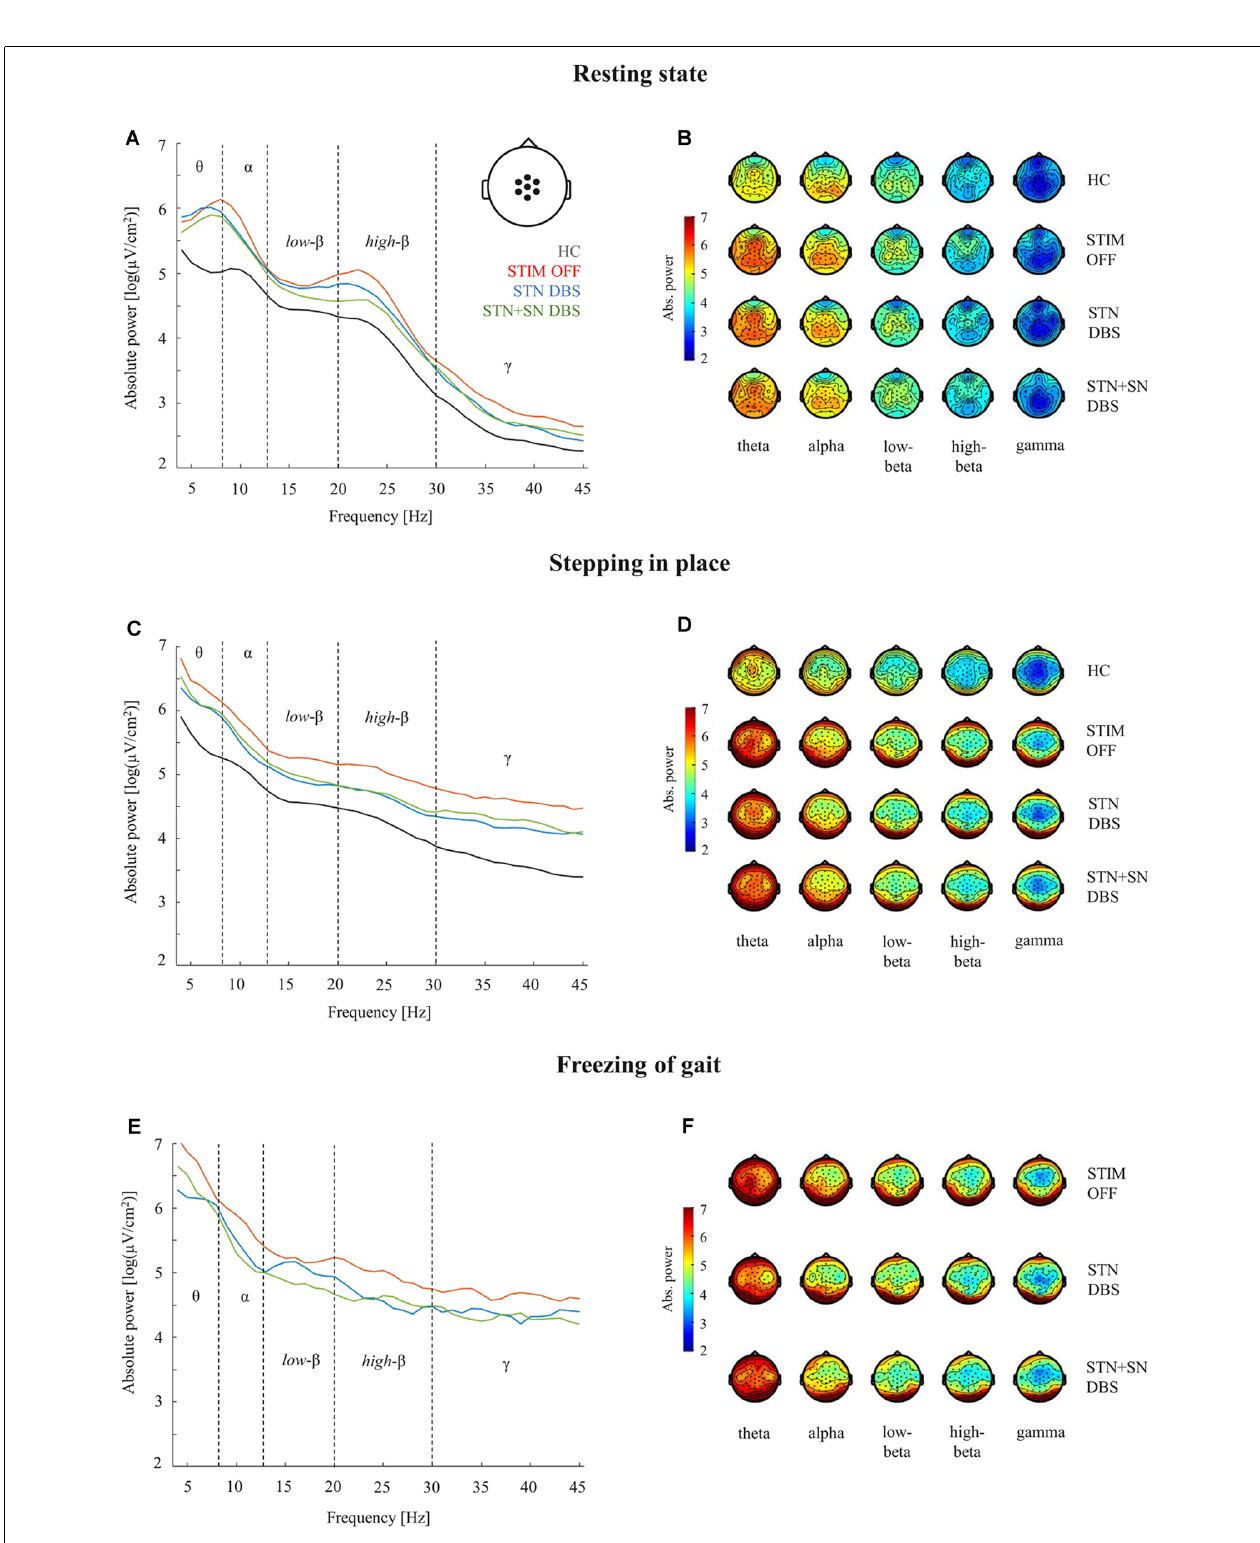
FIGURE 3 | Cortical activity during resting-state, stepping in place, and during freezing of gait episodes. Analyses of absolute power in healthy control persons and PD patients for the three DBS conditions were performed in five frequency bands (theta 4–8 Hz, alpha 9–13 Hz, low-beta 14–20 Hz, high-beta 21–30 Hz, gamma 31–45 Hz). Panels (A,C,E) : comparison of absolute power spectra in the central ROI (pictogram in panel A ). Panels (B,D,F) : topographies of absolute EEG power for healthy control persons (B,D) and for PD patients (B,D,F) during the three considered motor conditions.